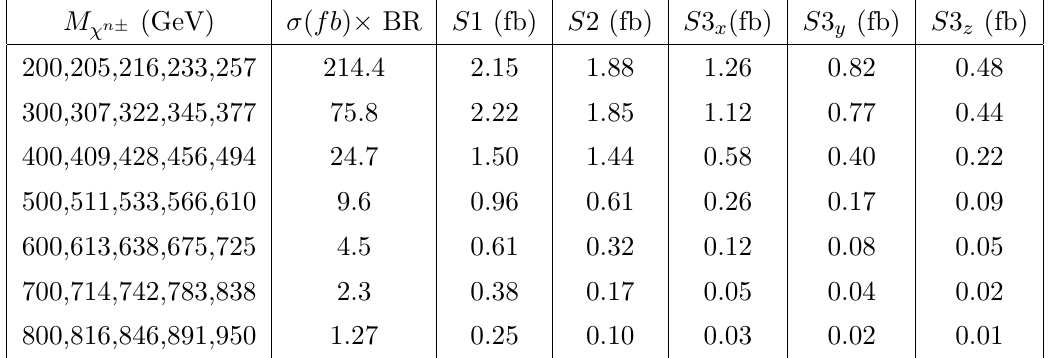
Table 4 . Signal cross-sections after passing the various selection criteria in the 2SSL channel at the 13 TeV LHC for di(cid:11)erent masses of the quintuplet. Here n runs from 0 to 4 in a given quintuplet. We assume BR( (cid:31) Q +1 l(cid:23)(cid:31) Q ) = 0.22 where l = e; (cid:22) and BR( (cid:31) Q +1 !